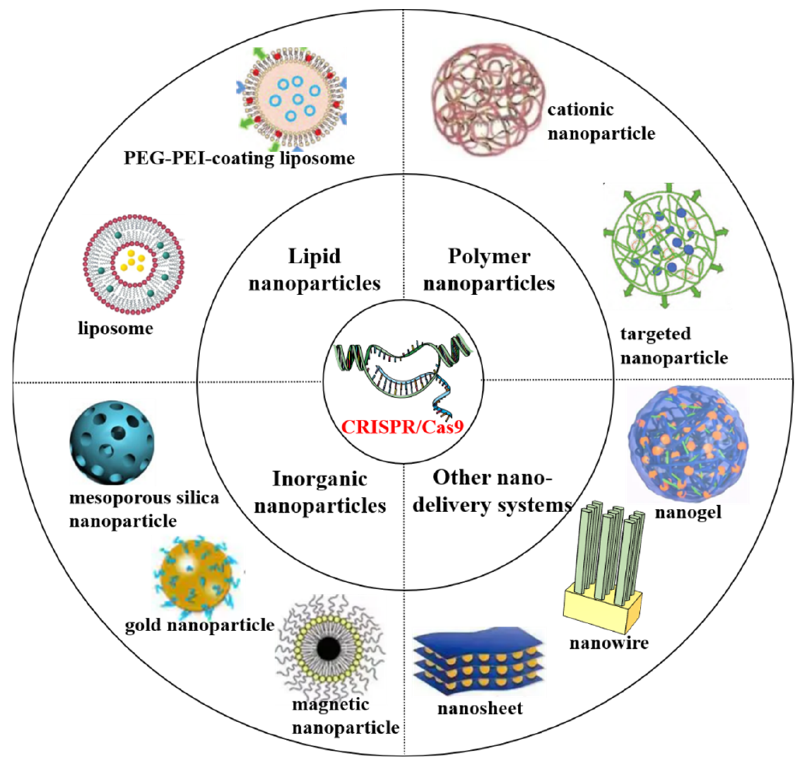
Figure 3. Different types of NPs-based CRISPR/Cas9